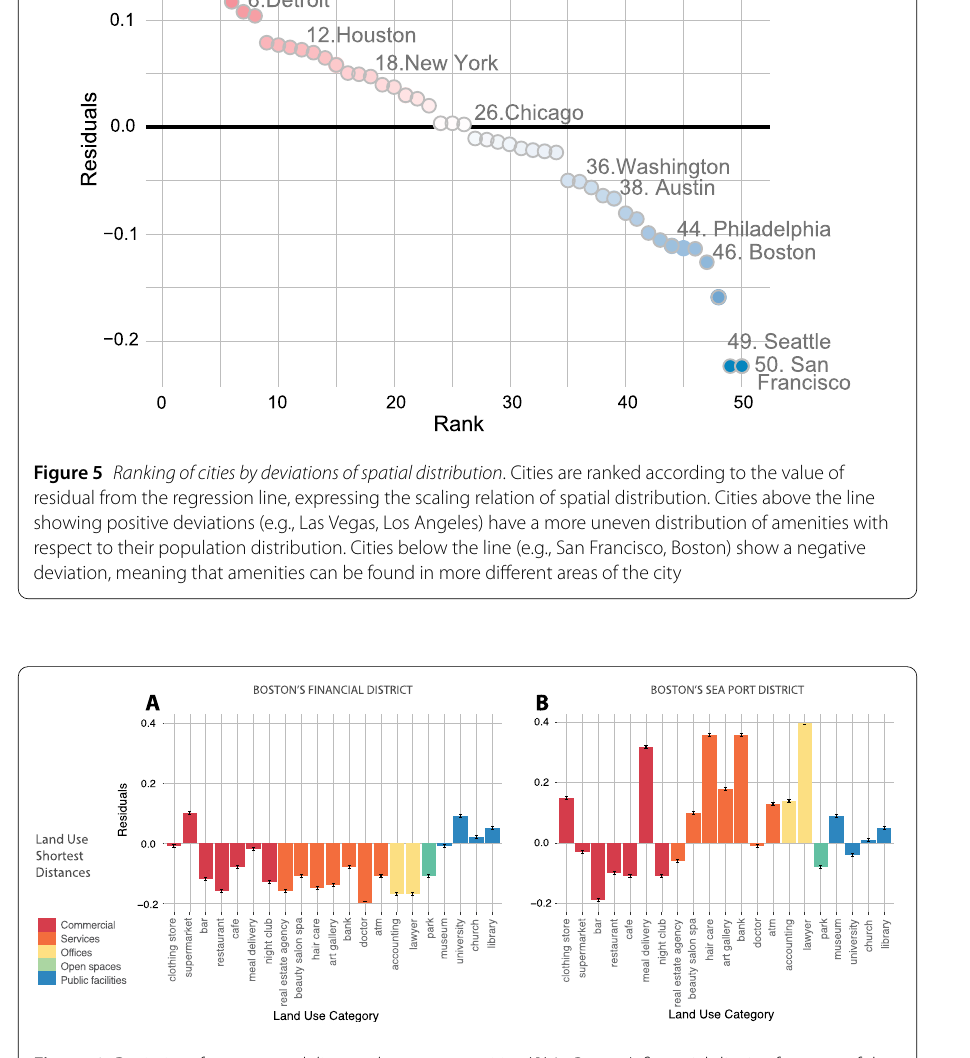
of two specific neighborhoods in Boston: the financial district and the seaport district, which are comparable in their day-to-day functioning. Figure 6 (full deviation values